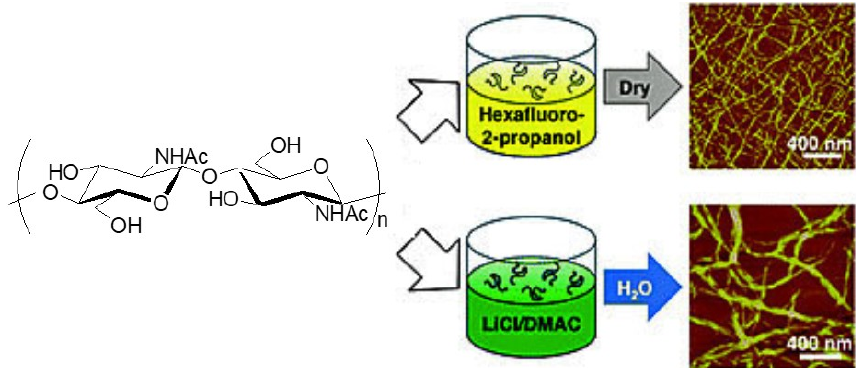
Figure 3. A schematic of the chitin nanofiber preparation routes (reproduced and adapted with permission from reference [28], Copyright 2010, Royal Society of Chemistry.